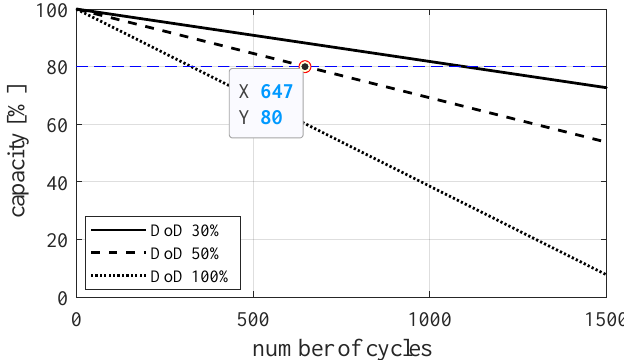
Figure 4. Capacity loss vs. cycles for lead-acid batteries [21].